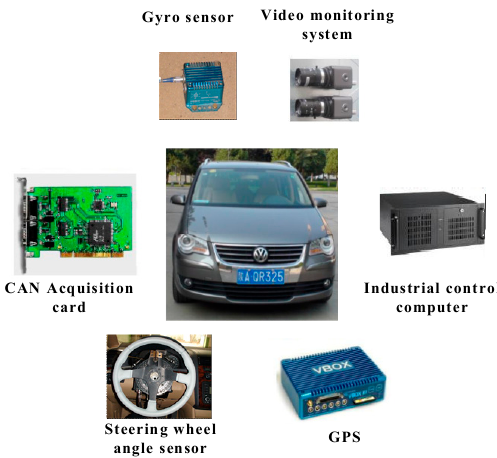
Figure 3. The experimental equipment.